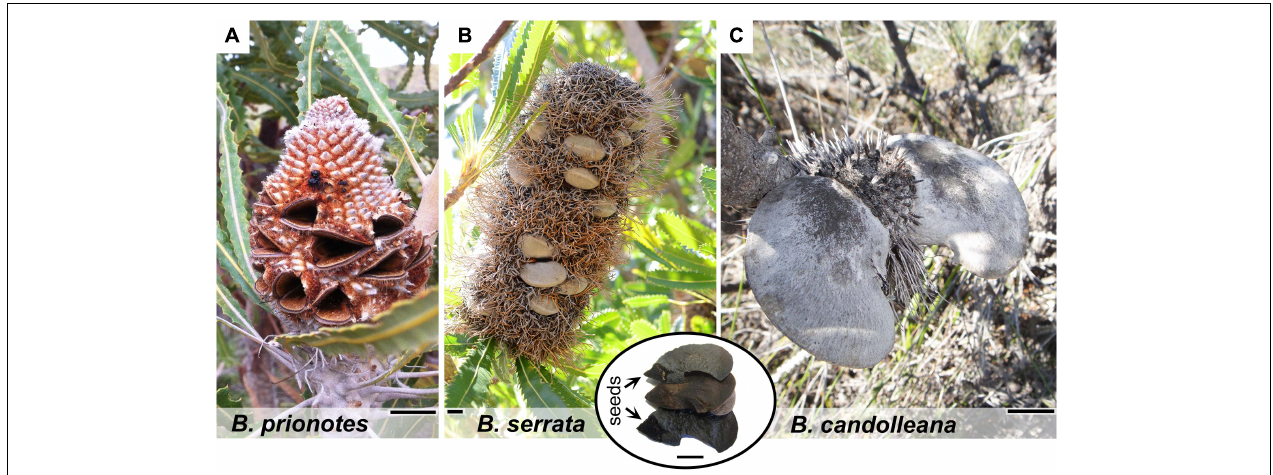
FIGURE 1 | Morphology of mature cones and follicles of different Banksia species. (A) Fruit of B. prionotes with open follicles and seeds already released. (B) Mature infructescence of B. serrata on the plant showing closed follicles surrounded by dried, flammable florets (photo by S. Ehrig, reproduced with permission). Inset: content of a single follicle with position of the seeds indicated. (C) Typical fruit of B. candolleana with large follicles. All scale bars: 1 cm.